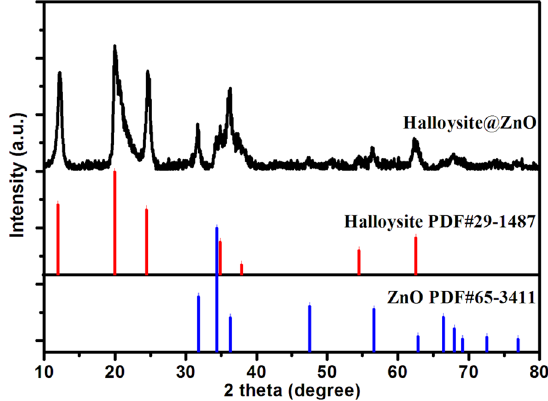
Figure 2. XRD patterns of as-prepared HNTs@ZnO nanocomposites.